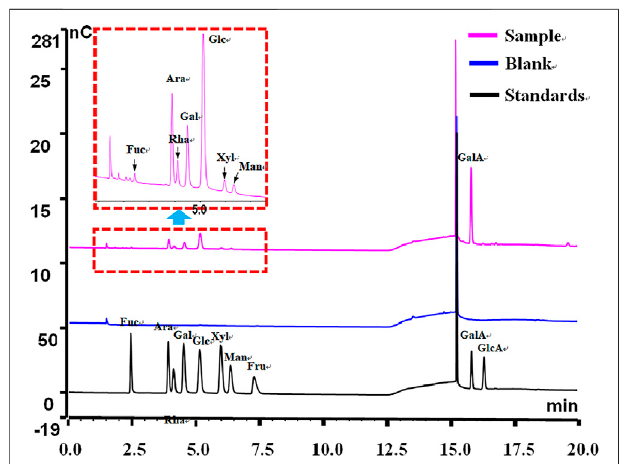
FIGURE 2 | Typical high-performance anion exchange chromatography (HPAEC) of Punica granatum peel polysaccharides (PPPs).